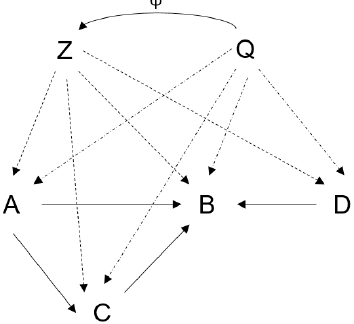
Figure 3. Illustration of the cone and